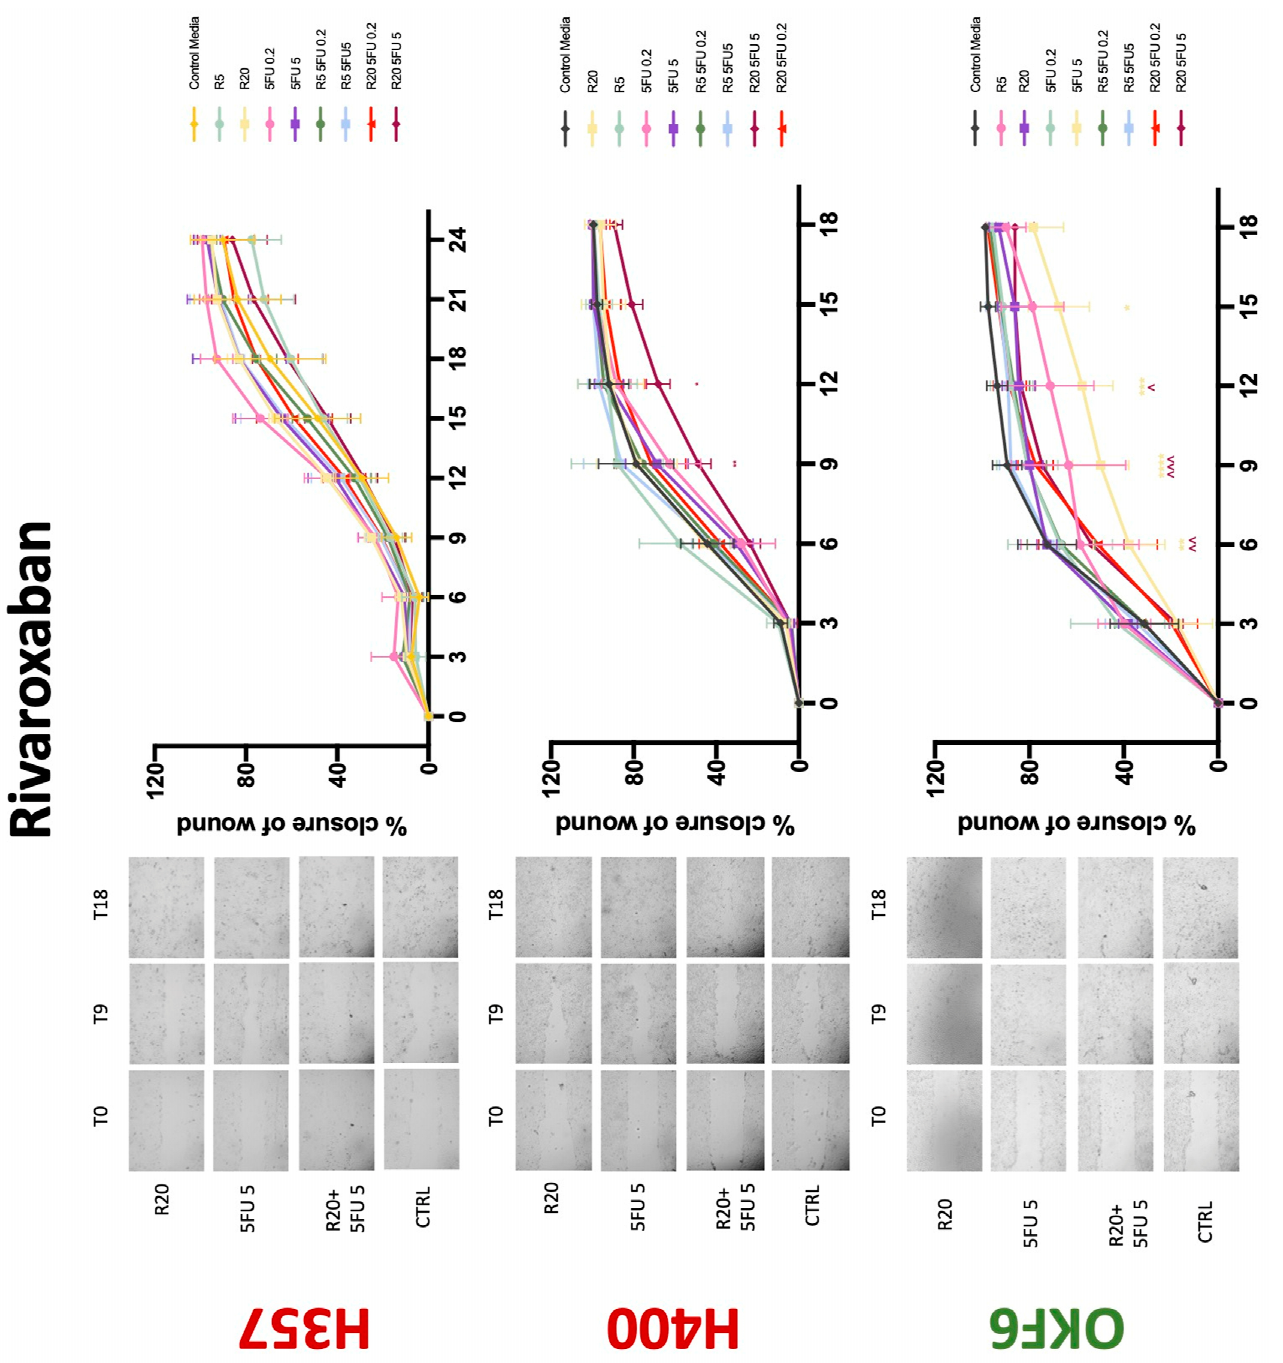
Figure 12. Wound healing assay . The effect of (5/20 µ M) rivaroxaban and (0.2/5 µ g/mL) 5-FU on H357, H400, and OKF6 cell migration. Data are represented as mean ± SD. Statistical significance is given as follows: * p < 0.05, ** p < 0.01, *** p < 0.005, **** p < 0.001; (*) compared to control group; ^^ p < 0.01, ^^^ p < 0.005; (^) compared to respective 5-FU groups.